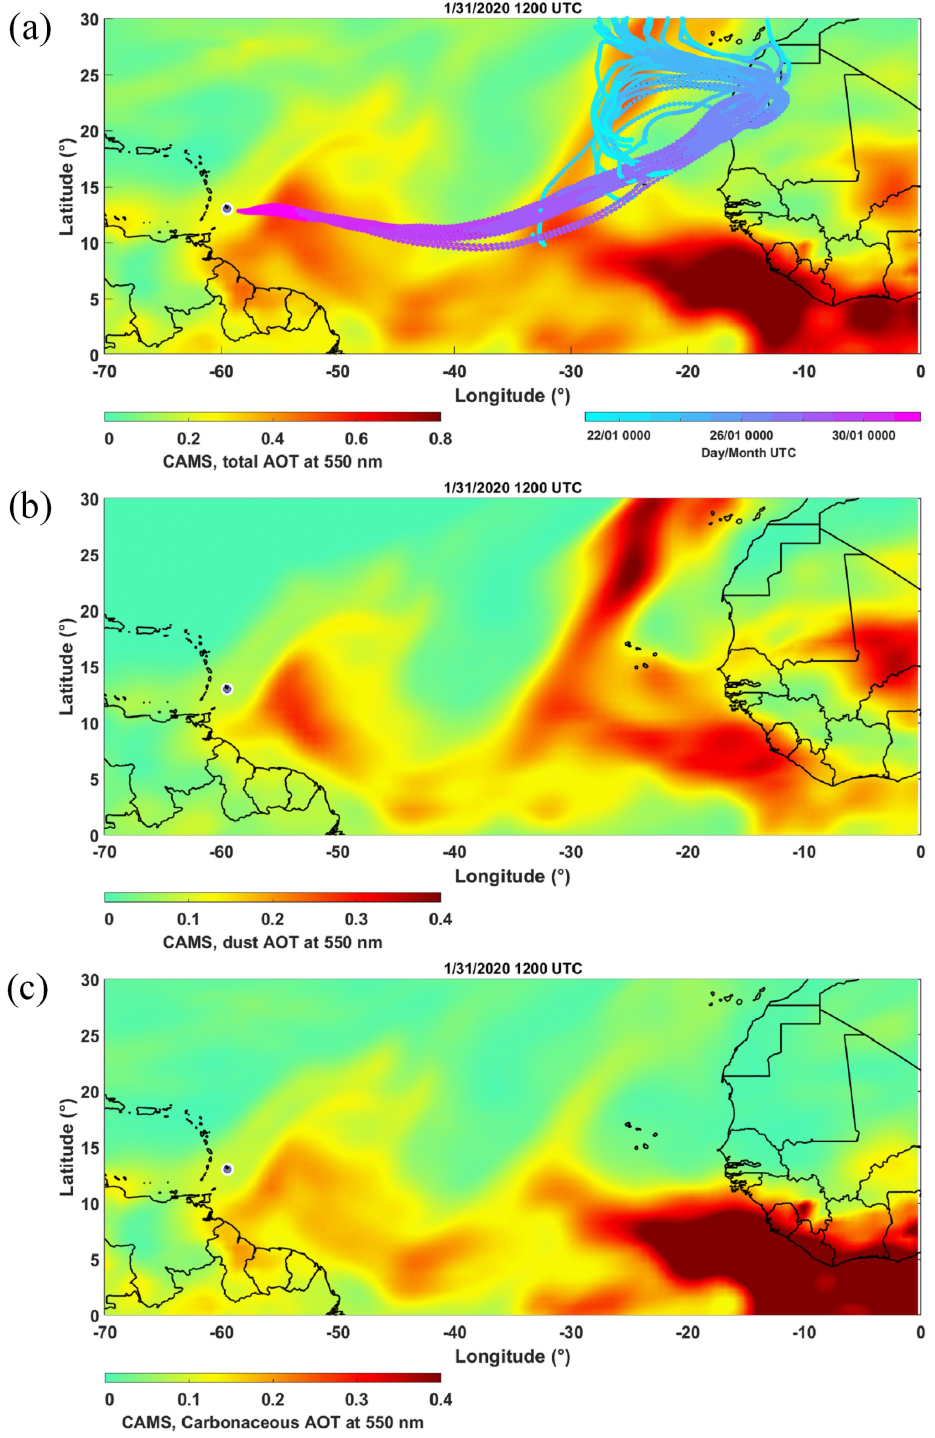
Figure 10. Aerosol optical thickness (AOT) derived from the CAMS numerical simulations on 31 January at 12:00UTC: (a) total AOT, (b) AOT of dusts, and (c) AOT of carbonaceous components (black carbon and organic carbon). The back trajectories computed via HYSPLIT in ensemble mode are plotted in panel (a) for an initial altitude of 700ma . m . s . l . over the flight area close to Barbados, corresponding to rectangle ABCD in Fig.